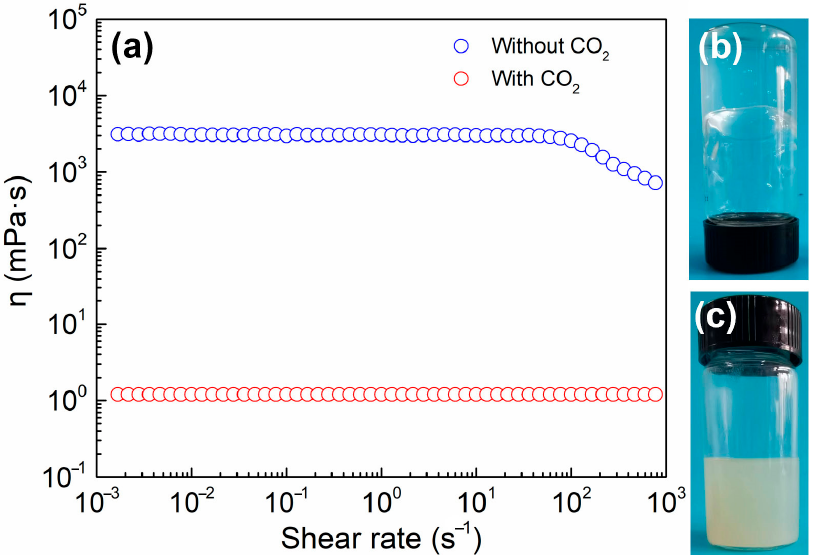
Figure 1. ( a ) Steady rheology of SA/cyclen (300 mM) in the absence or presence of CO 2 at 25 °C; ( b ) the physical appearance of SA/cyclen (300 mM) in the absence of CO 2 at 25 °C; ( c ) the physical appearance of SA/cyclen (300 mM) in the presence of CO 2 at 25 °C.